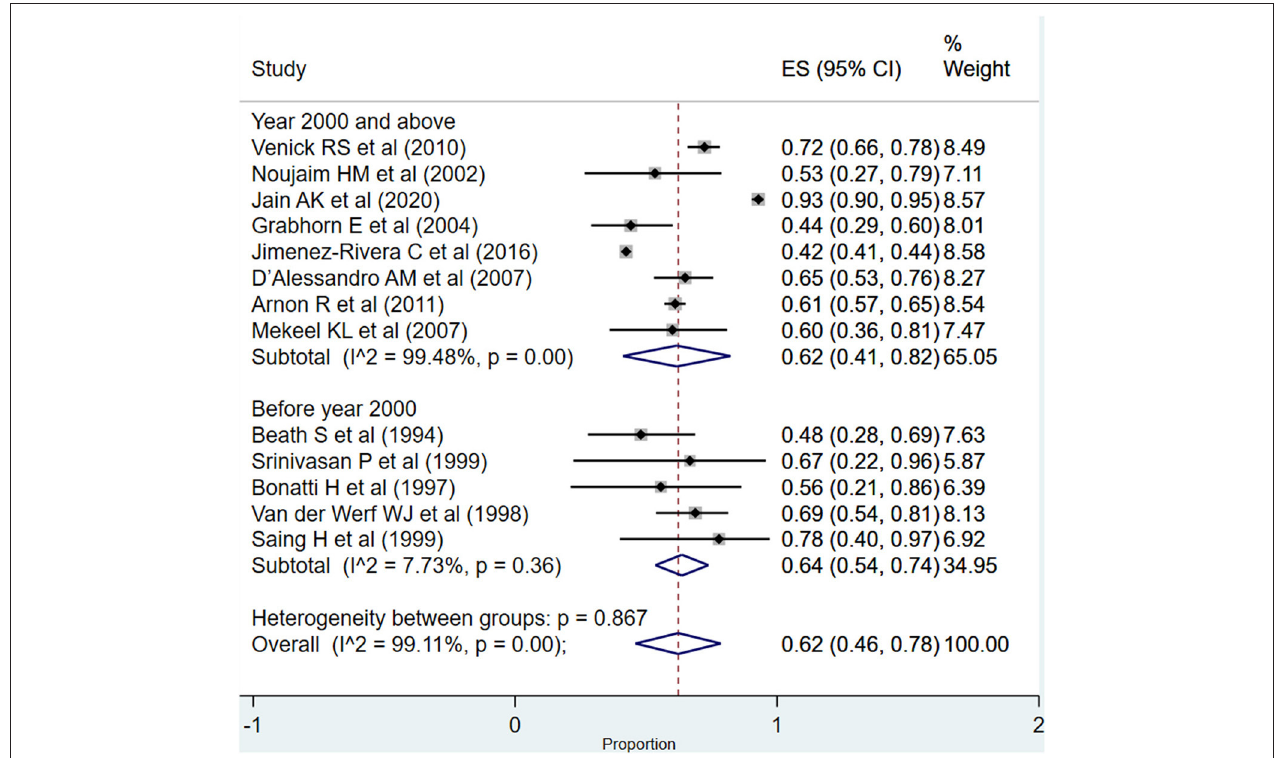
FIGURE 6 | Pooled graft survival rate among infants between > 1 and 5 years post-liver transplantation.